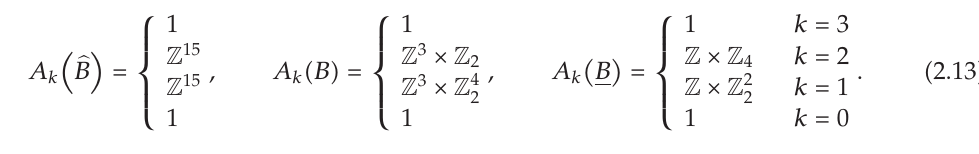
(cid:2) 1 (cid:3) (cid:2) red dots (cid:3) and Σ (cid:2) 1 (cid:3) B